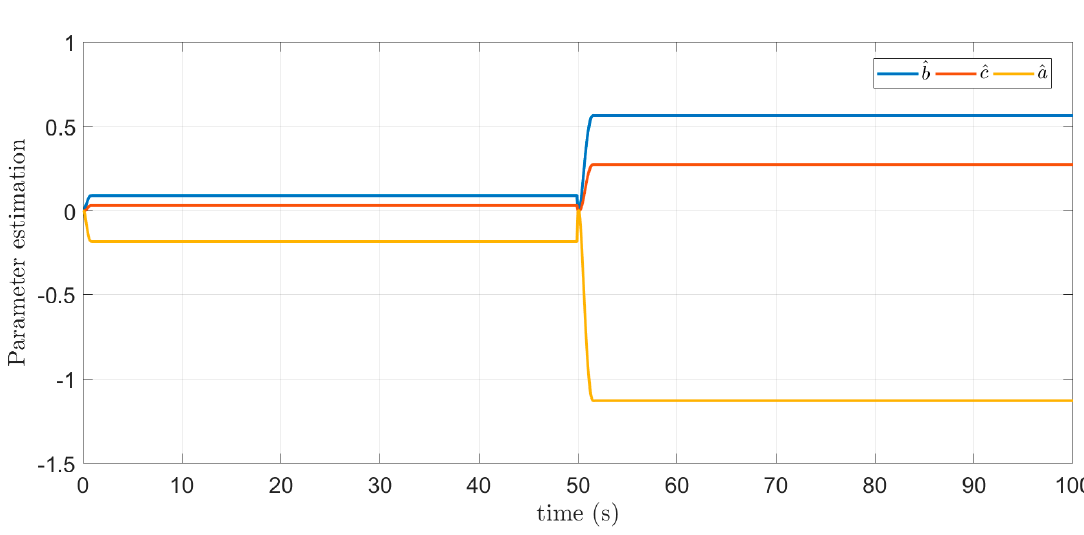
Figure 13. Simulation results of the control input of robust adaptive heading control.